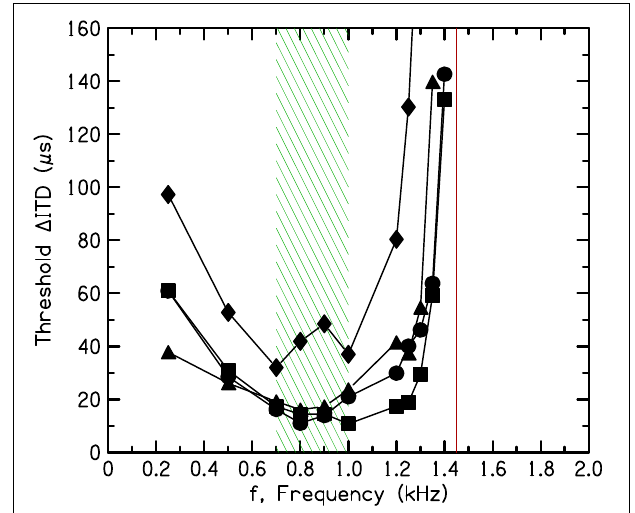
FIGURE 6 | Threshold interaural time differences as a function of frequency for four listeners measured by Brughera et al. (2013). The shaded rectangle indicates the frequency region of greatest sensitivity. The vertical solid line shows the brick